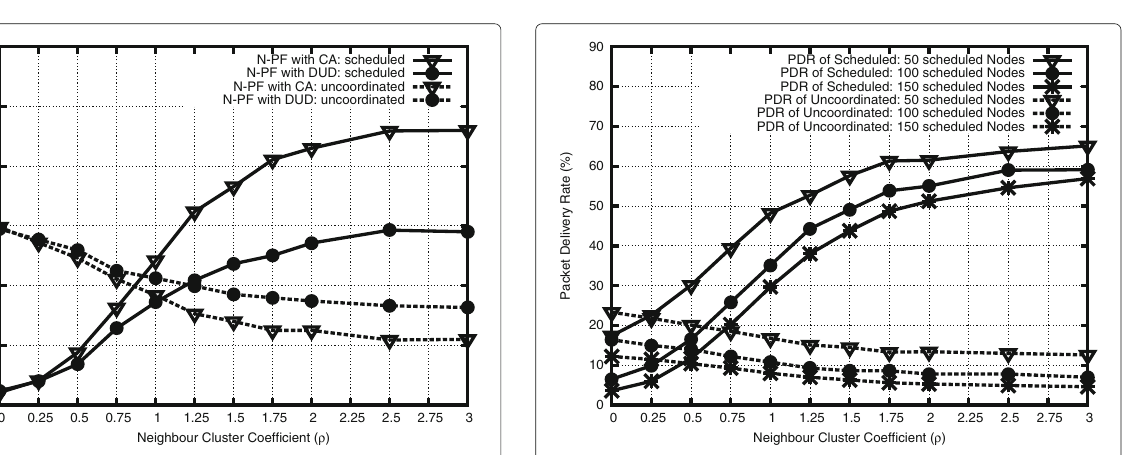
ing the blocking rate for uncoordinated node, shown in Fig. 10. We conclude by showing in Fig. 13 the Jain index for N-PF with CA and DUD algorithms as a function of ρ , for different values of the CCA threshold. In all cases